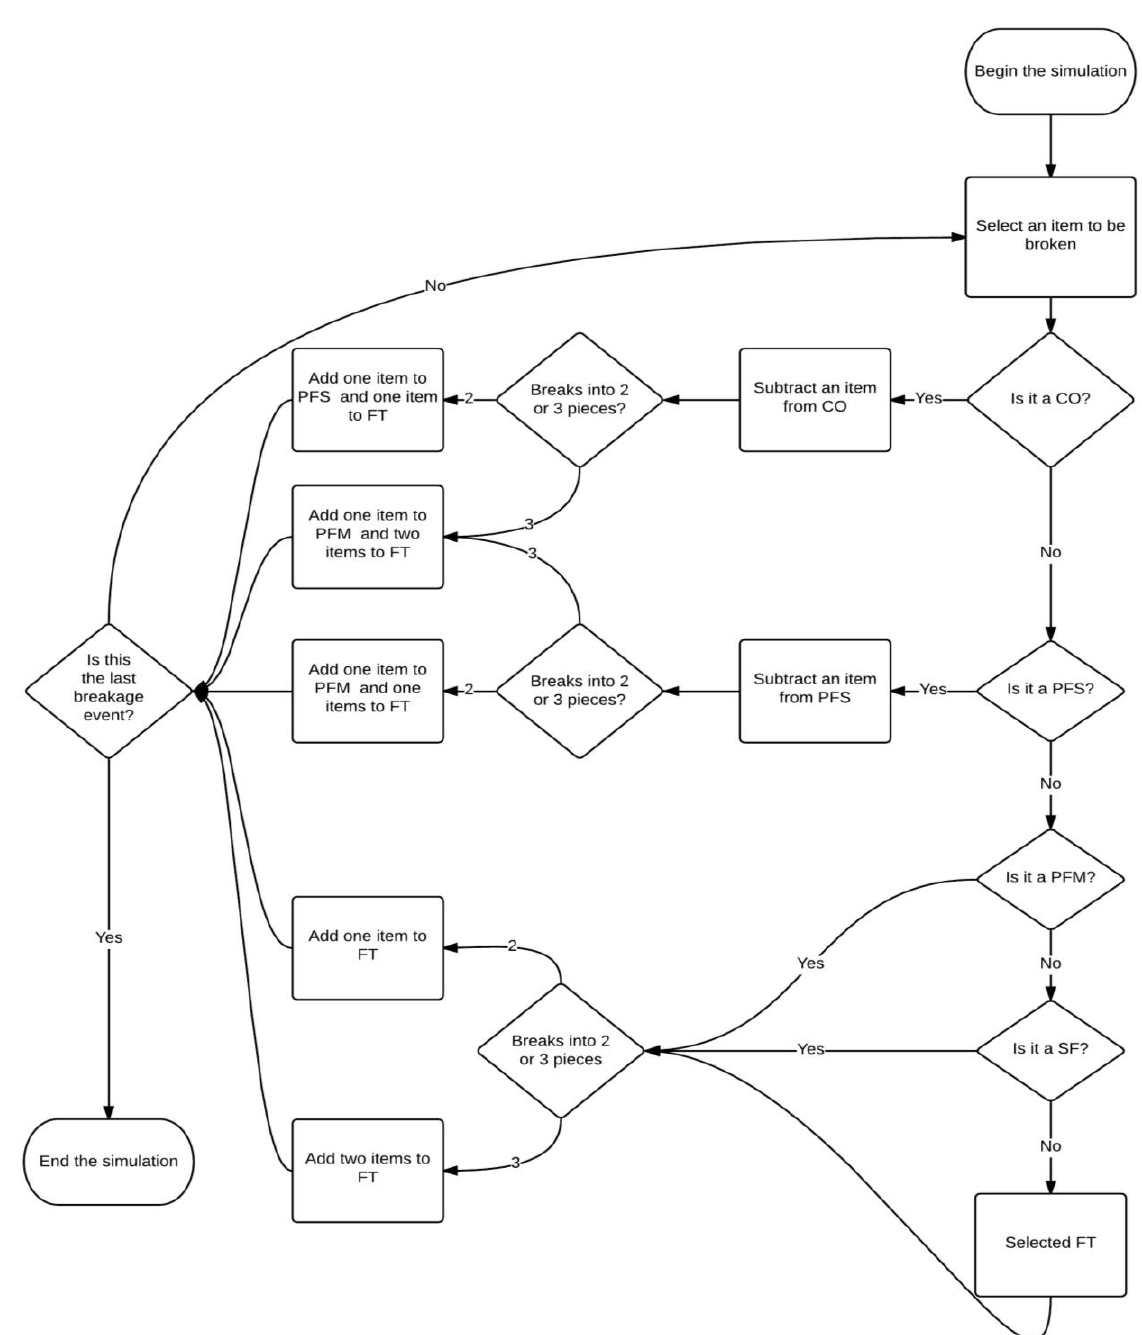
Figure 2. A flowchart describing the model’s algorithm. An item to be broken is randomly selected. The frequencies of the different breakage categories making up the assemblage are changed in accordance with the type of item selected. CO = complete flake, PFS = proximal flake with a single breakage, PFM = proximal flake with multiple breakages, SF = split flake, FT =